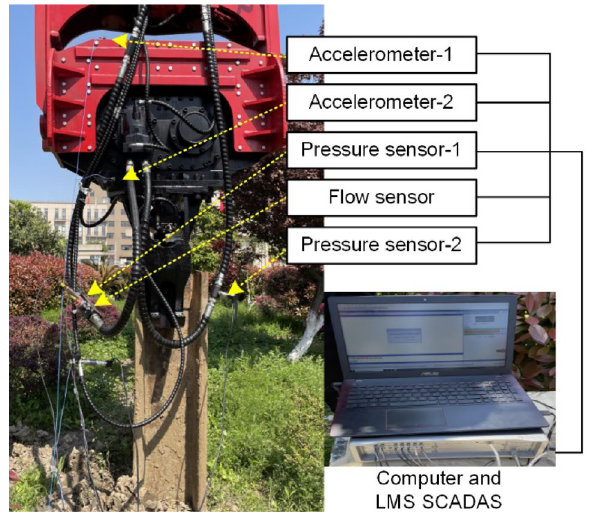
Fig. 4 Field test system diagram